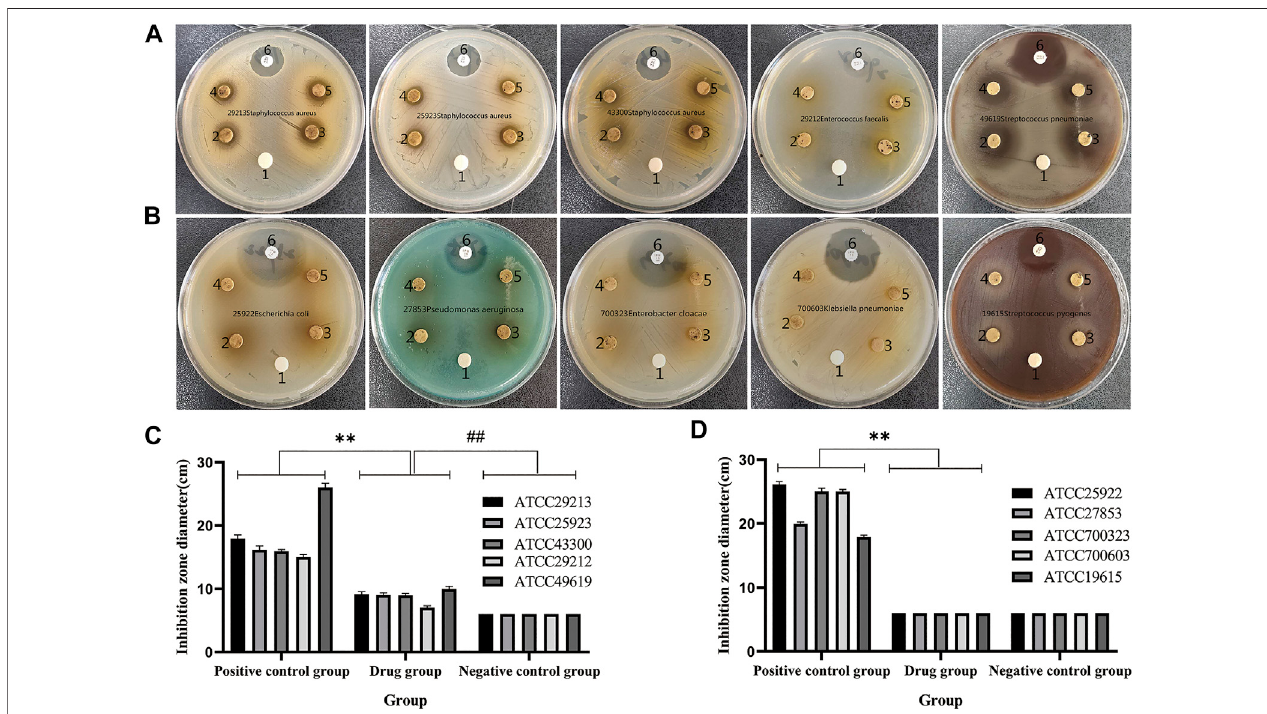
FIGURE 10| Antibacterial activity test. (A and C) QXWWD had asigni fi cantinhibitory effect on thesebacteria, (B and D) QXWWD had no obvious inhibitory effect on these bacteria.